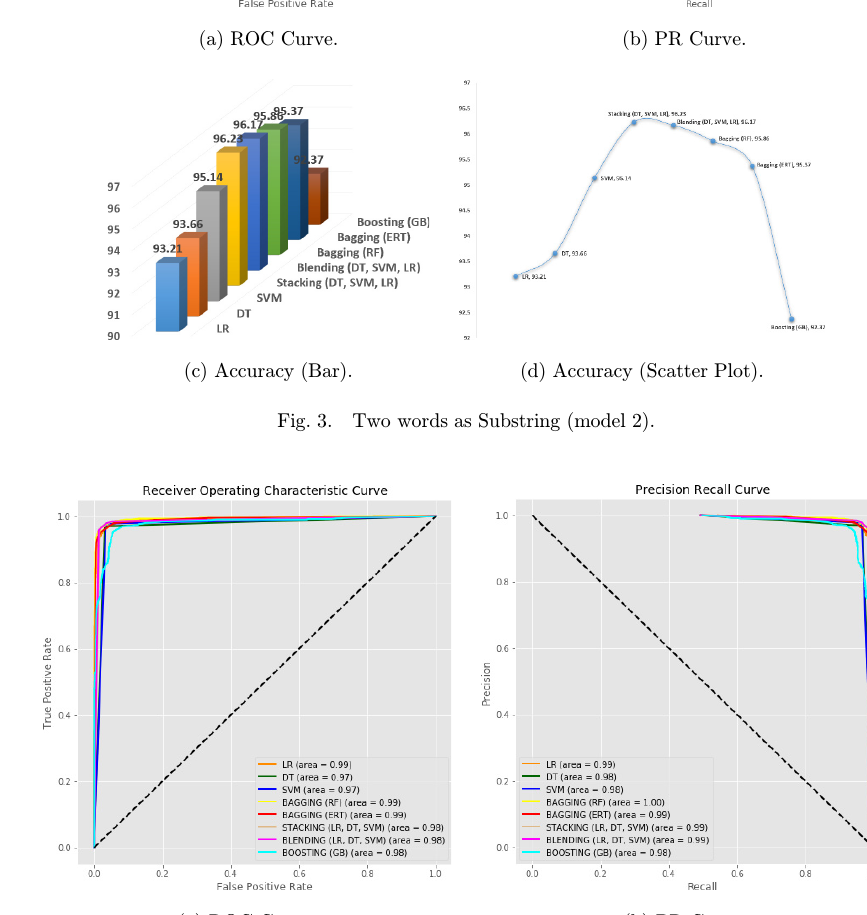
(a) ROC Curve. (b) PR Curve. Fig. 4. One word as Substring (model